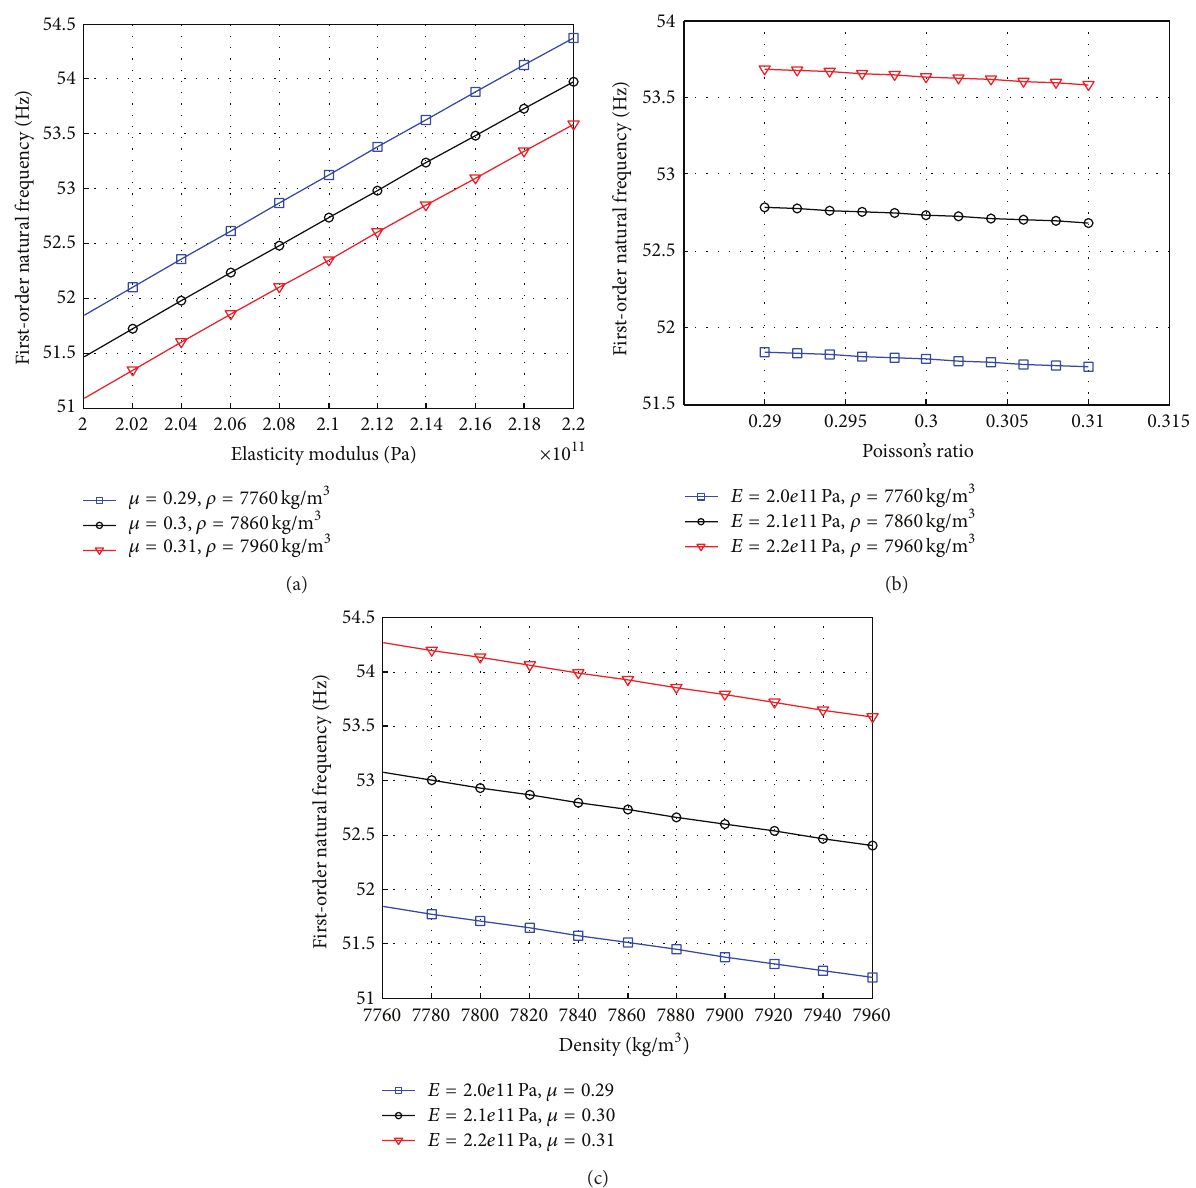
Figure 7: The change of the first-order natural frequency along with the variables of the frame. (a) The change along with elasticity modulus. (b) The change along with Poisson’s ratio. (c) The change along with